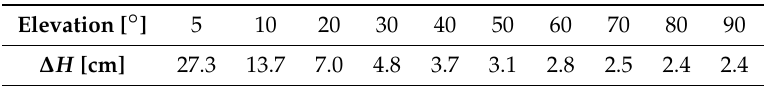
Table 1. Surface roughness for different satellite elevation angles computed from the Rayleigh criterion for GPS-L1 carrier wavelength ( λ = 0.19